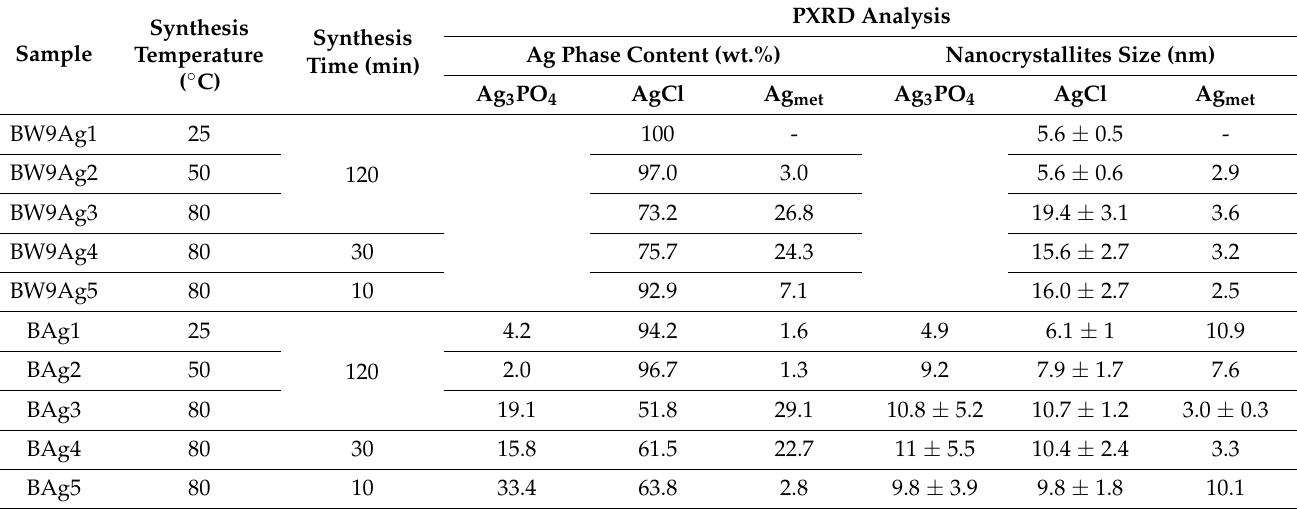
Figure 2. X-ray diffractograms of nanocomposites synthesized at different temperatures and times using ( a , c ) brewery by-product BW9 and ( b , d ) brewery product B. Table 2. Phase content and nanocrystallites size of BW9 and B